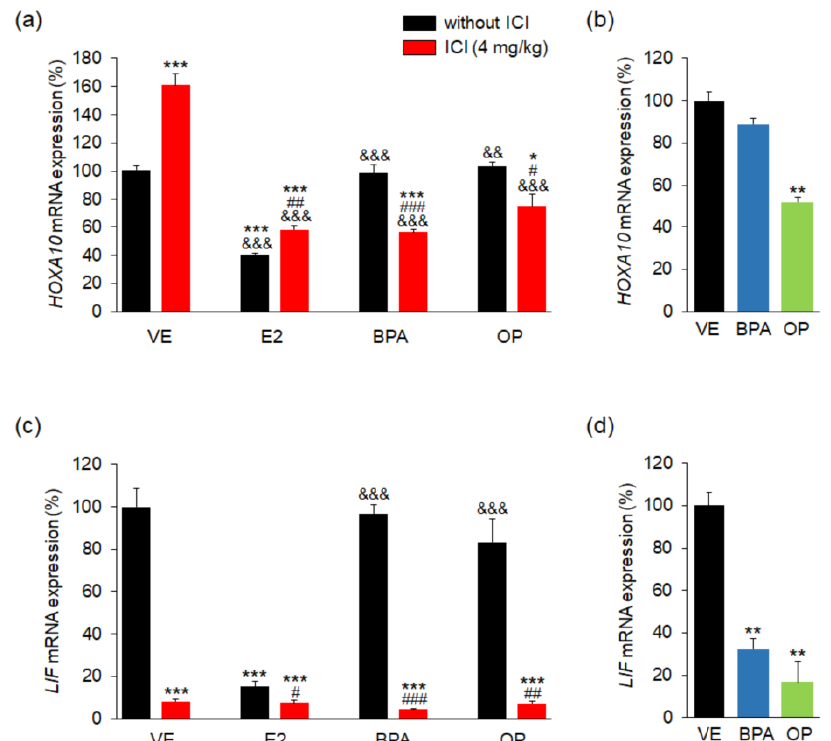
Figure 4. E2, BPA, and OP decreased the expression of HOXA10 and LIF in maternal uterus and implantation sites. The expressions of HOXA10 and LIF genes were measured by real-time PCR and were normalized to that of 18S ribosomal RNA (RN18S). ( a ) mRNA levels of HOXA10 were significantly different after E2 and EDs + ICI treatment in maternal uterus; ( b ) the mRNA level of HOXA10 was significantly decreased by OP treatment in implantation sites; ( c ) mRNA levels of LIF were significantly low in the ICI, E2 and EDs + ICI groups in maternal uterus ( d ) mRNA levels of LIF were markedly lowered by BPA or OP treatment in implantation sites. Both mRNA levels of HOXA10 and LIF were significantly low in the combination BPA + ICI and OP + ICI than that in BPA- and OP-alone in maternal uterus. Statistical significance was determined by two-way ANOVA. * p < 0.05 vs. VE, ** p < 0.01 vs. VE, *** p < 0.001 vs. VE, # p < 0.05 EDs + ICI vs. EDs, ## p < 0.01 EDs + ICI vs. EDs, ### p < 0.001 EDs + ICI vs. EDs, && p < 0.01 vs. ICI, &&& p < 0.001 vs. ICI. n = 5 mice per group for uterus, n = 3 mice per group for implantation sites. Treatments: E2; 40 µg/kg/day, BPA; 100 mg/kg, OP; 100 mg/kg, ICI; 4 mg/kg.